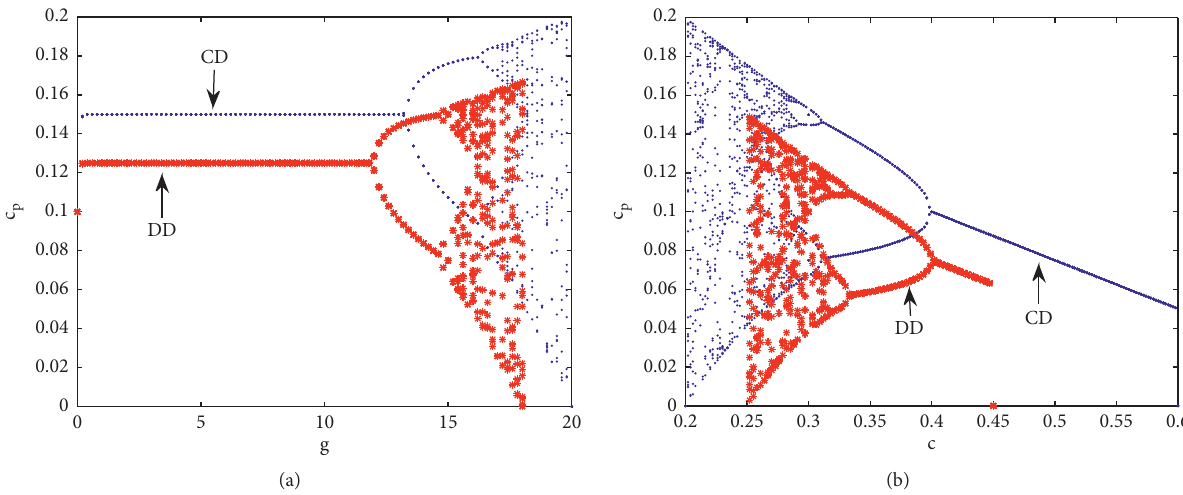
Figure 5: Bifurcation diagrams for the decisions of the platform operator: (a) c